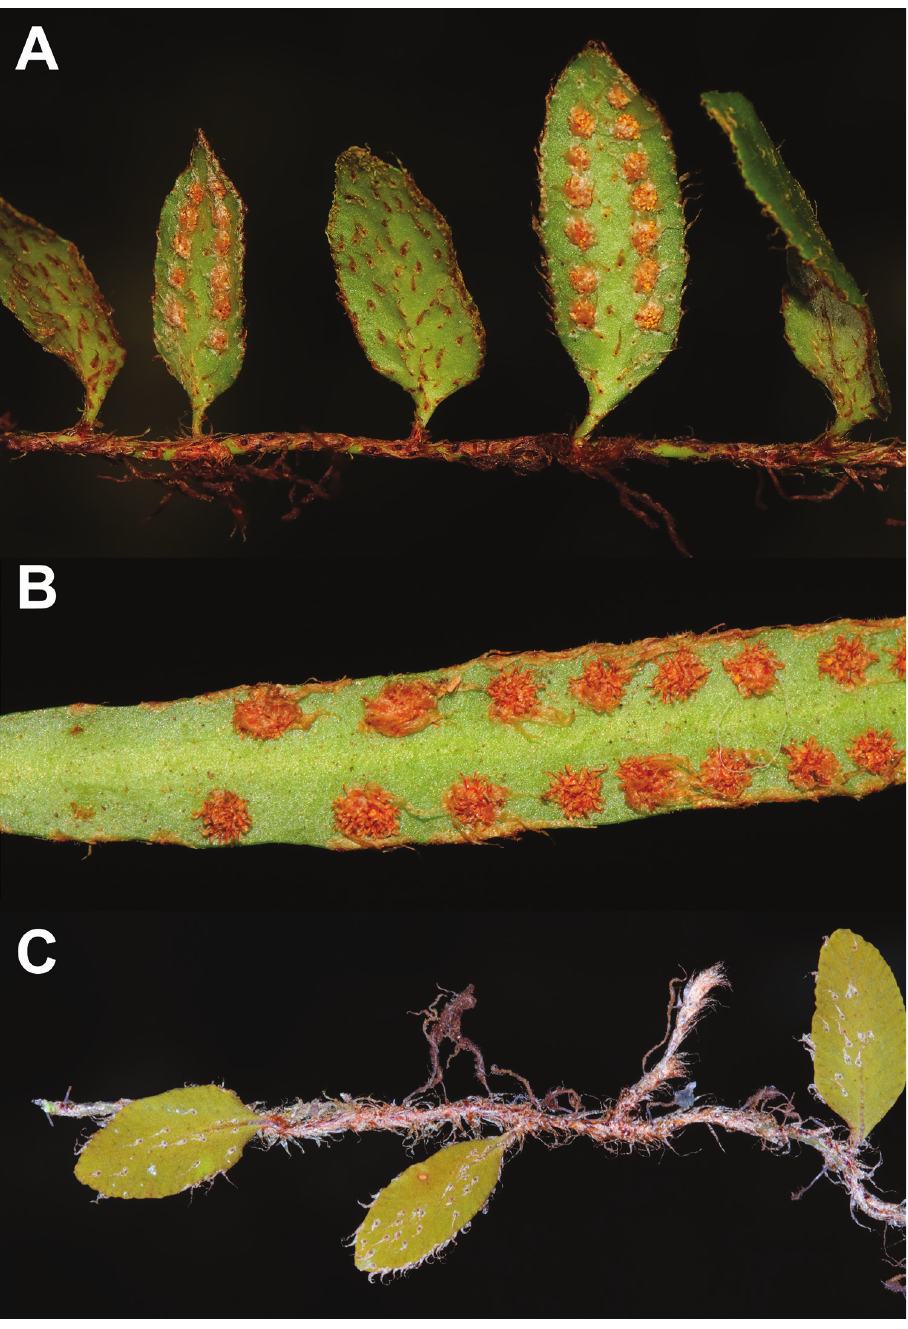
Figure 4. Adetogramma chrysolepis (Hook.) T.E.Almeida. A Fertile and sterile fronds B Detail of abaxial surface of fertile frond, showing laminar scales and paraphyses C Juvenile sterile leaves. (A) and (B) from C. Martín 730 (SI), (C) from C. Martín 479